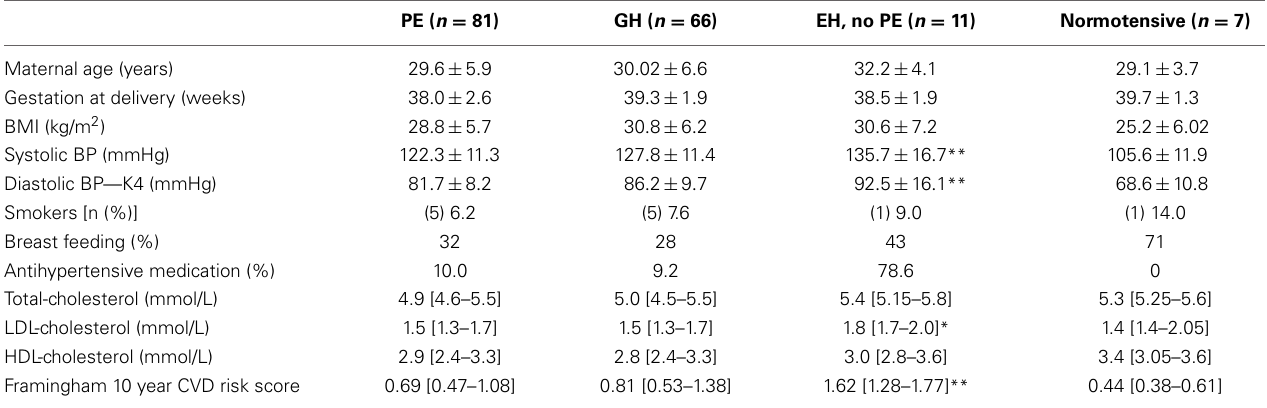
Table 1 | Maternal demographic and laboratory